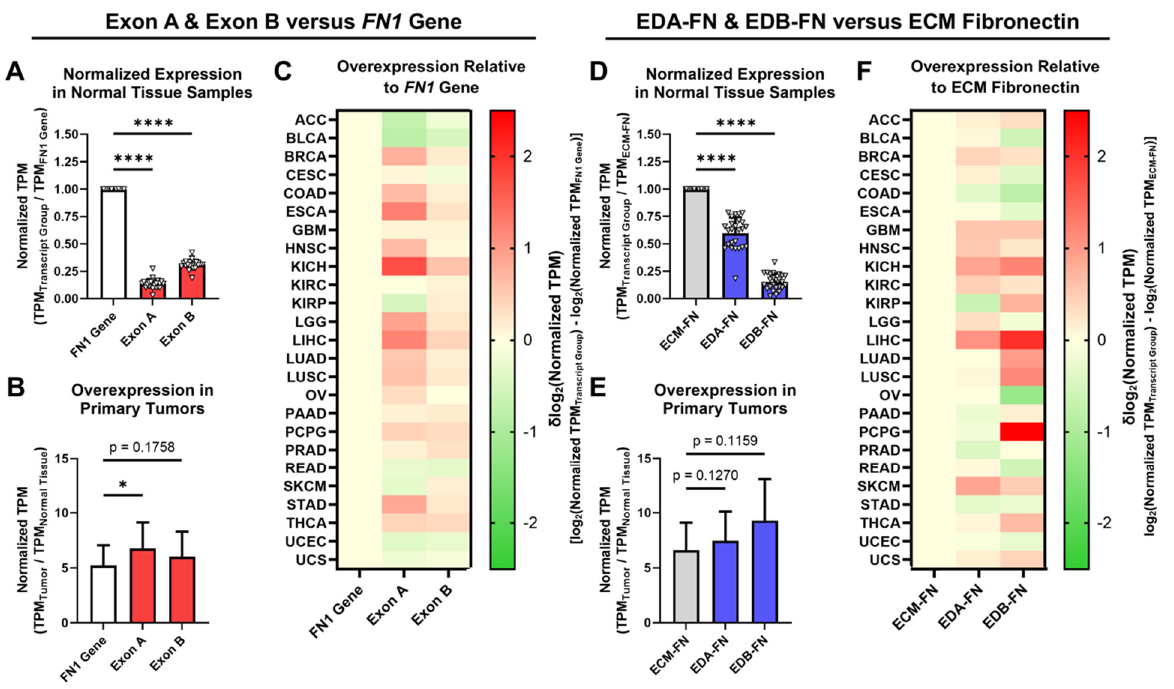
Figure 4. Expression of oncofetal FN in normal tissues and primary tumors. ( A ) Average expression of Exon A and Exon B normalized to the FN1 gene in normal tissue samples ( n = 25). ( B ) Average overexpression of the FN1 gene, Exon A, and Exon B in primary tumors normalized to corresponding normal tissues ( n = 25). ( C ) Heat map showing overexpression of Exon A and Exon B normalized to the FN1 gene by cancer type. ( D ) Average expression of EDA-FN and EDB-FN normalized to ECM-FN in normal tissue samples ( n = 25). ( E ) Average overexpression of ECM-FN, EDA-FN, and EDB-FN in primary tumors normalized to corresponding normal tissues ( n = 25). ( F ) Heat map showing overexpression of EDA-FN and EDB-FN normalized to ECM-FN by cancer type. Tissue types were excluded from analysis if the number of samples in any cohort was fewer than 10. Significance: *, p < 0.05; ****, p < 0.0001.